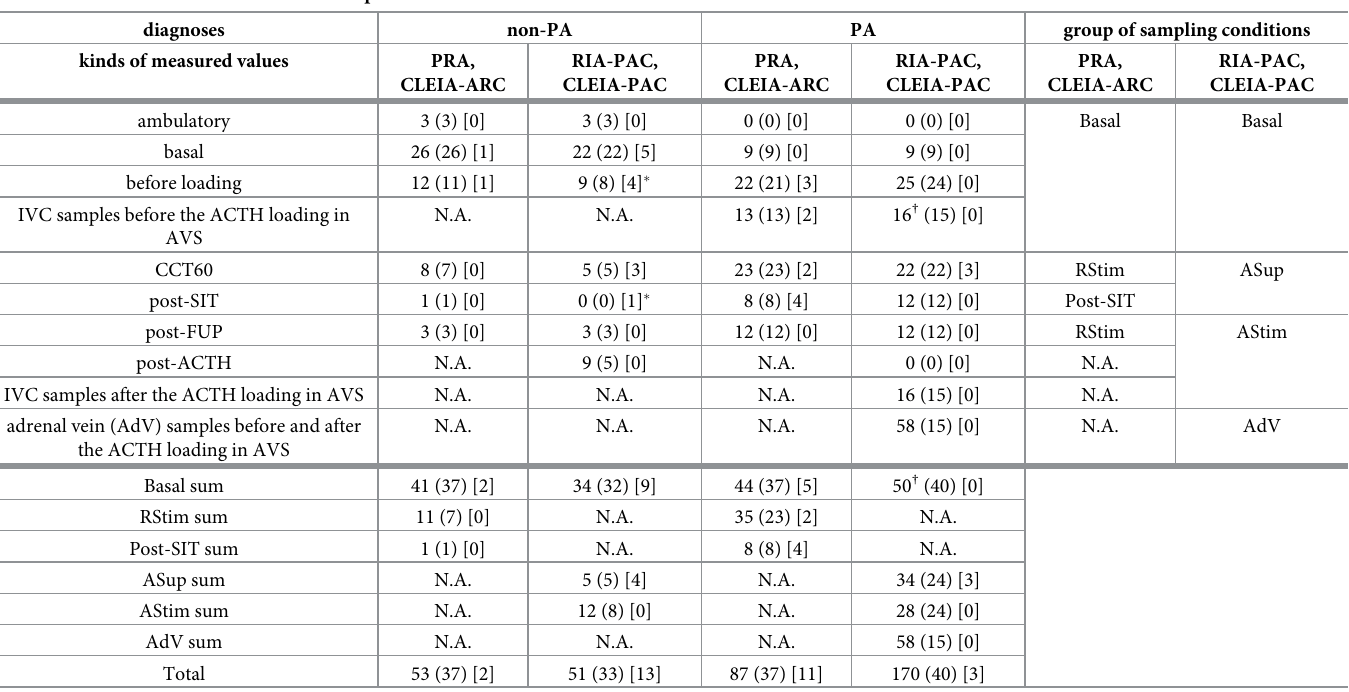
Table 1. Numbers and classifications of